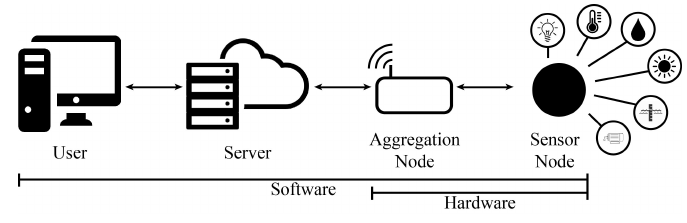
Figure 1. System Architecture [7] c (cid:13) 2019